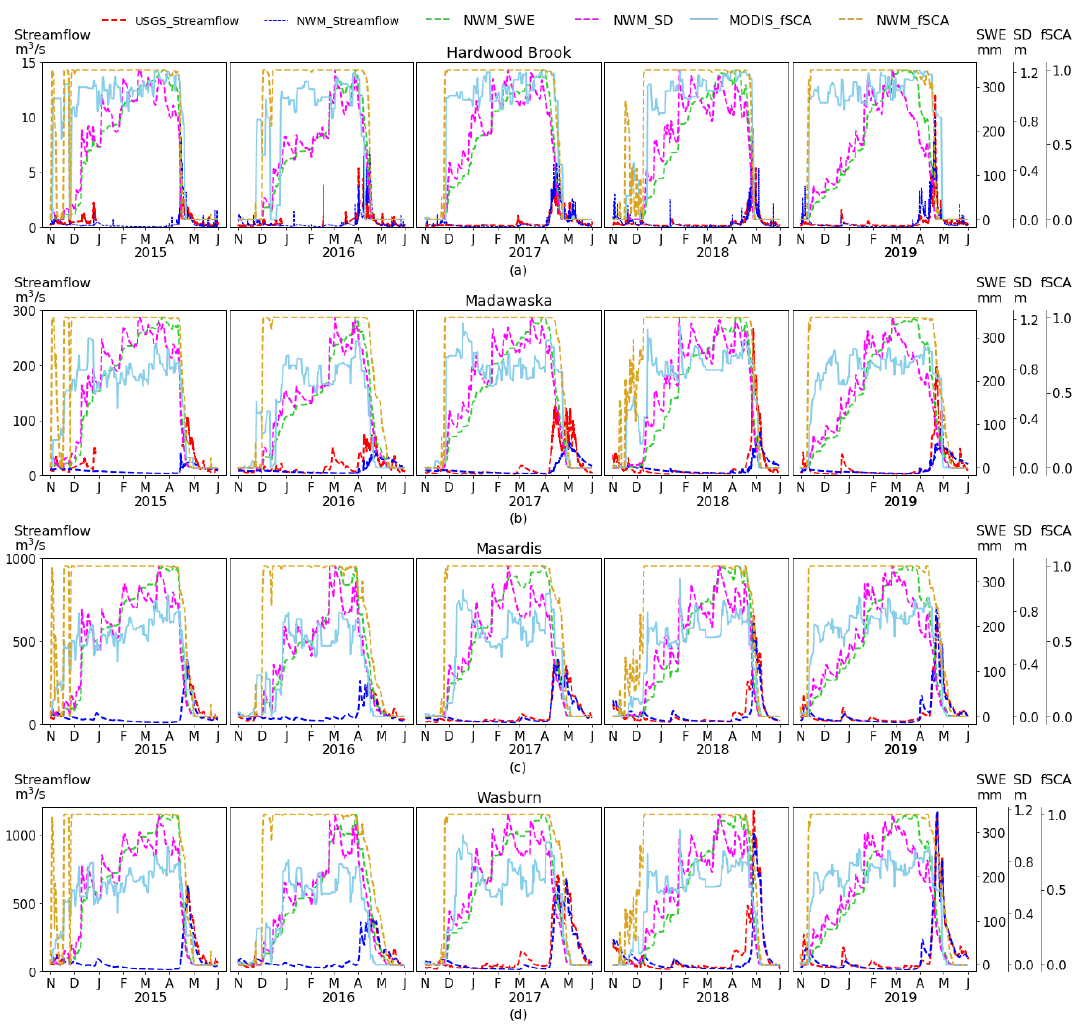
Figure 10. Runoff, fractional snow cover, snow water equivalent, and snow depth from NWM V2.0 estimates and streamflow from USGS gages at ( a ) Harwood Brook; ( b ) Madawaska; ( c ) Masardis; ( d ) Washburn stations from 2014 – 2019 snow accumulation and melt seasons.